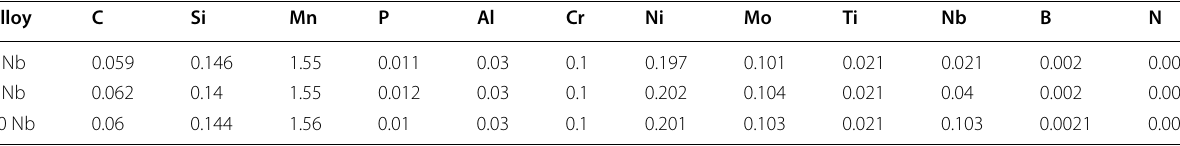
Table 1 Chemical composition of the alloys (wt.%) Alloy